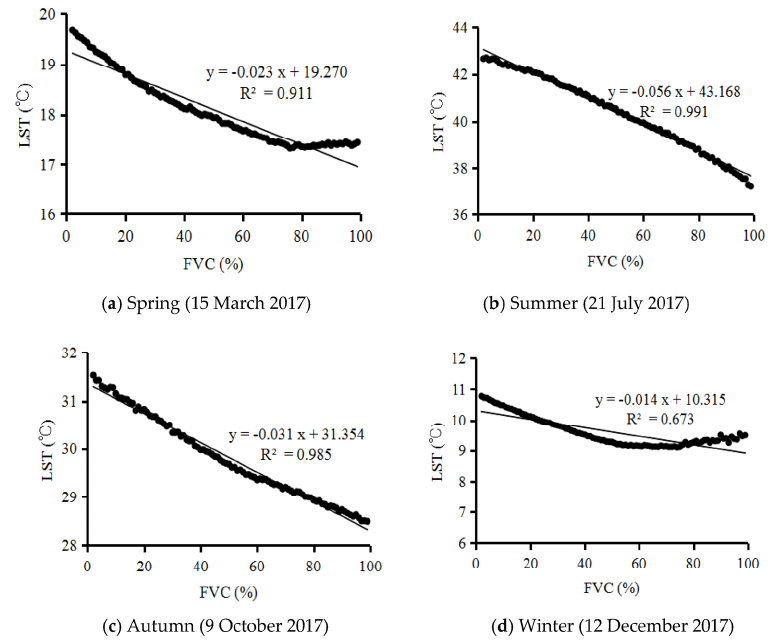
Figure 6. Scatter plots of the LST and FVC in the study area in the four seasons. Urban vegetation has a cooling effect on the thermal environment, especially in summer. In this study, the SCR and LST were calculated based on each FVC category, shown in Figure 7. Although the LST generally decreased as FVC increased (Figures 6 and 7), the relationship between the LST and FVC was not as entirely linear in the whole range of 0 – 100% FVC (Figure 6) as was that between LST and percent ISA in the whole range of 0 – 100% percent ISA (Figure 4). Different from the decrease in SHR with in- creasing percent ISA in summer, the SCR increased with increasing FVC in summer (Figure 7). With increasing FVC, the SCR of vegetation increased from 3.7 in the 0 – 25% FVC category to 7.5 in the 75 – 100% FVC category in summer. This indicates that the cooling effect of vegetation increased with increasing FVC in summer, though LST de- creased with increasing FVC.